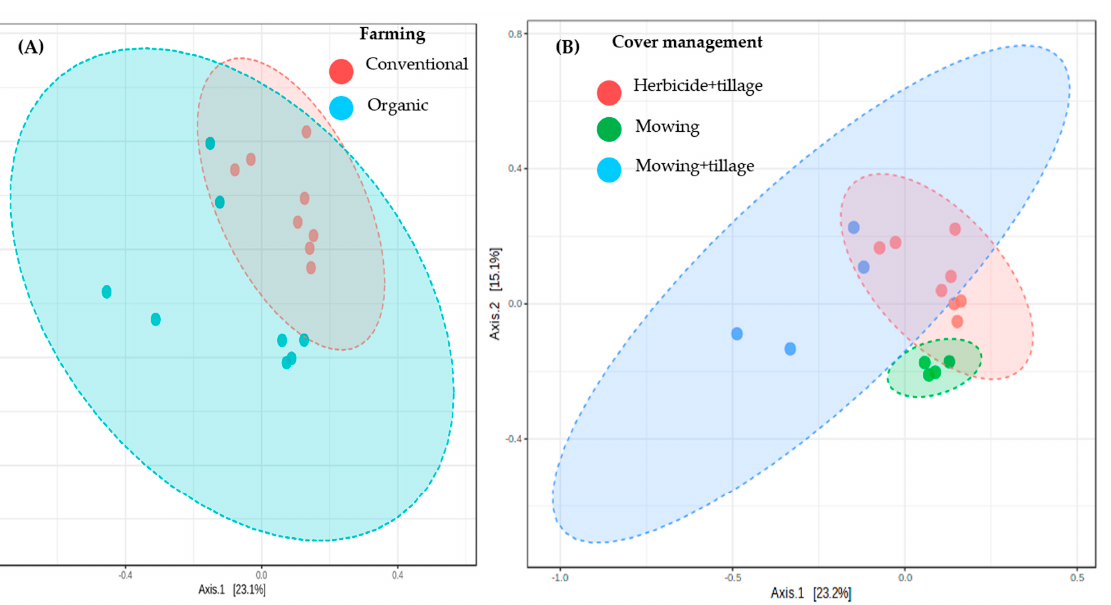
Figure 3. Effect of farming ( A ) and cover management ( B ) on bacterial beta diversity in vineyards’ soils. Ordination method PCoA; distance method: Bray-Curtis index; statistical method: PER- MANOVA. Ellipses mean that 95% of the data fell inside the